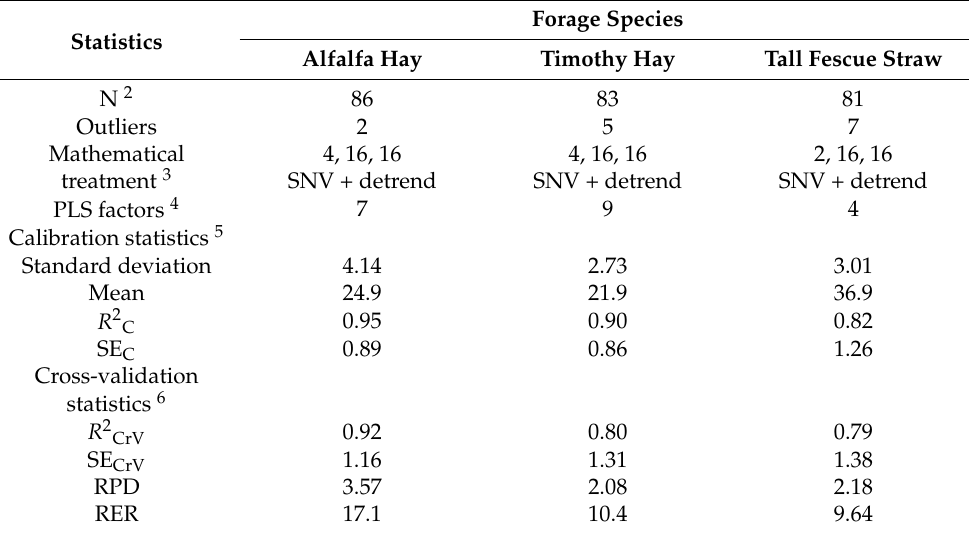
Table 5. Calibration and cross-validation statistics for NIRS analysis of undigested NDFom (uNDF, % of DM) using in vitro fermentation procedure (experiment 2) 1